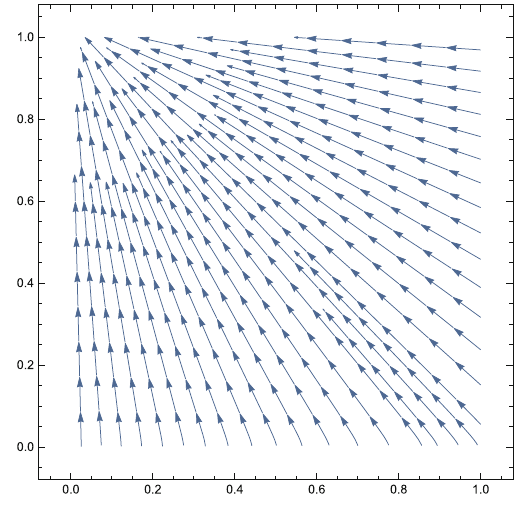
Fig. 6 Phase space diagram for the dynamical system (16), (17), (21) in the space of variables (cid:8) b ,(cid:8) (cid:2) for n < 1 and (cid:8) r = 10 − 4 . The attractor is the point B